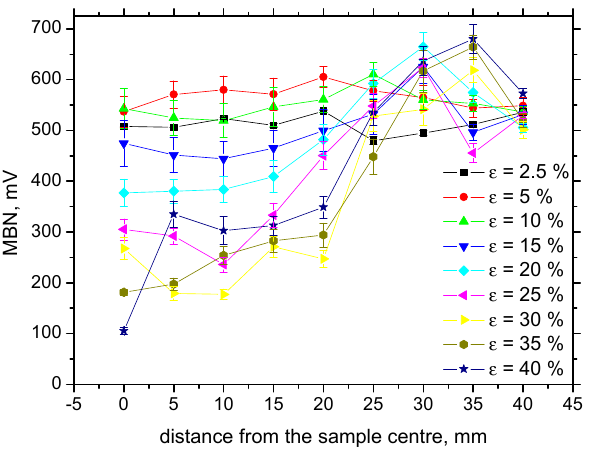
Figure 12. Evolution of MBN along with ε , RD.